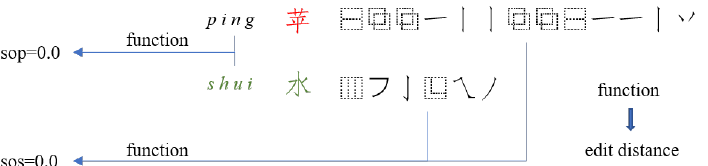
Figure 3. Our method calculates the phonetic similarity ( sop ) and glyph similarity ( sos ) between 水 and 苹 based on the edit